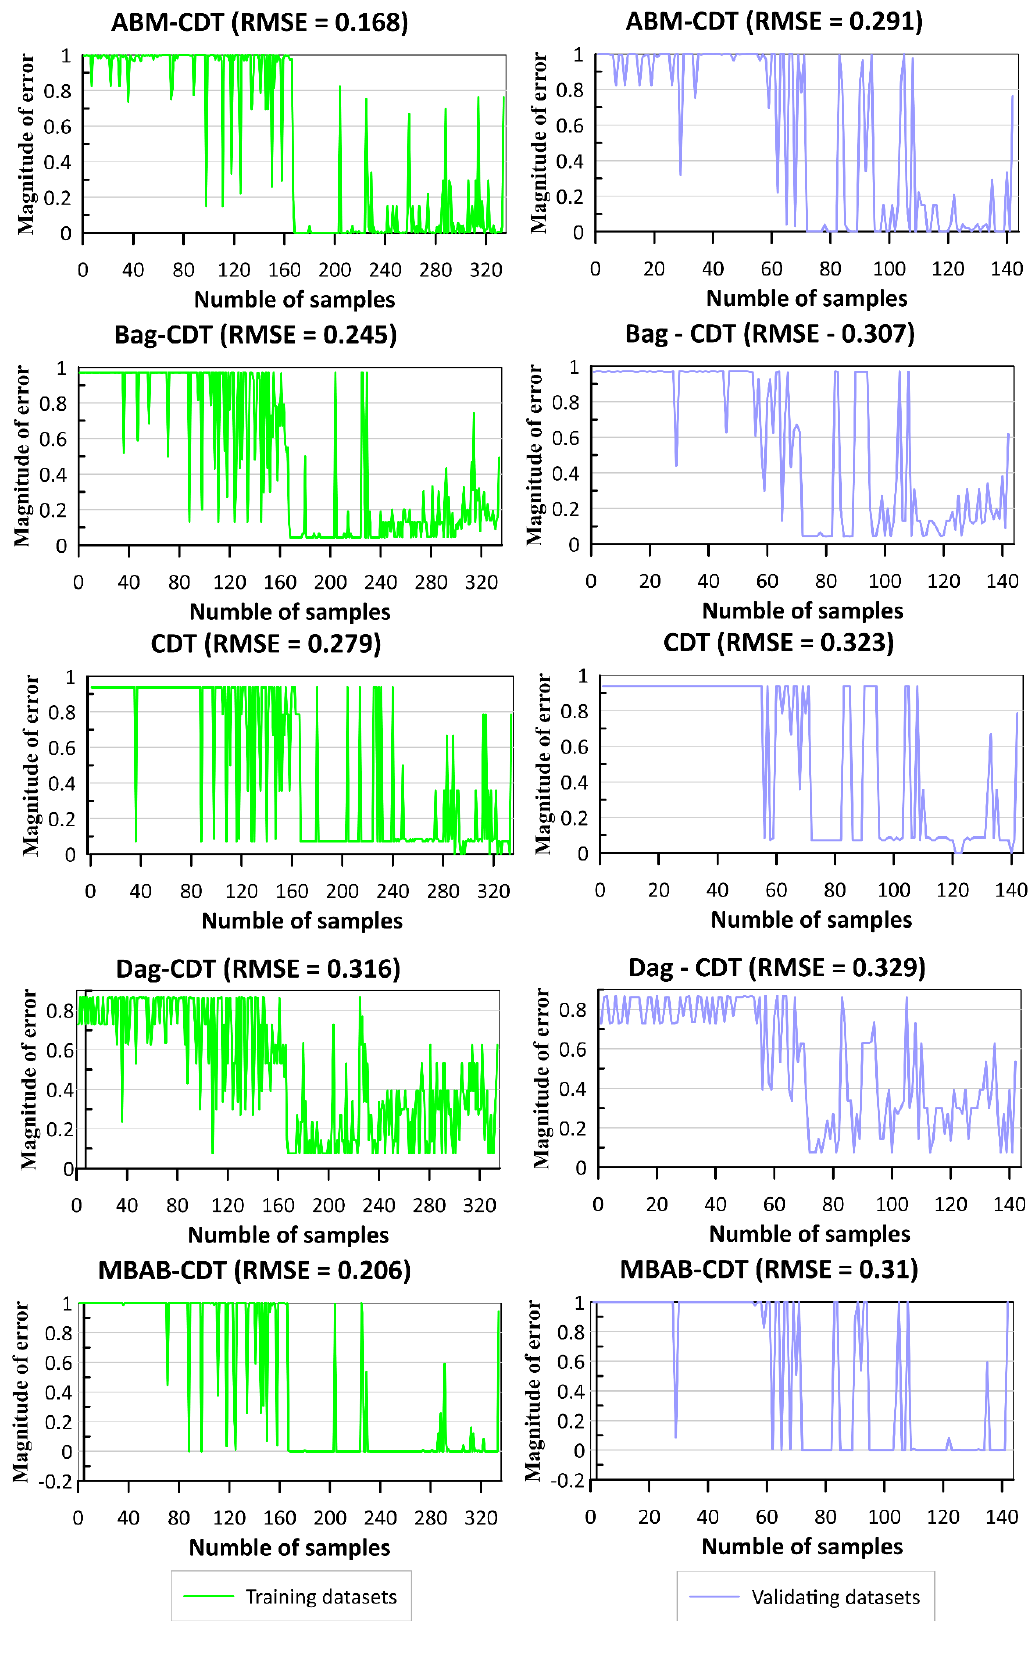
Figure 7 . Analysis of RMSE of models . Figure 7. Analysis of RMSE of